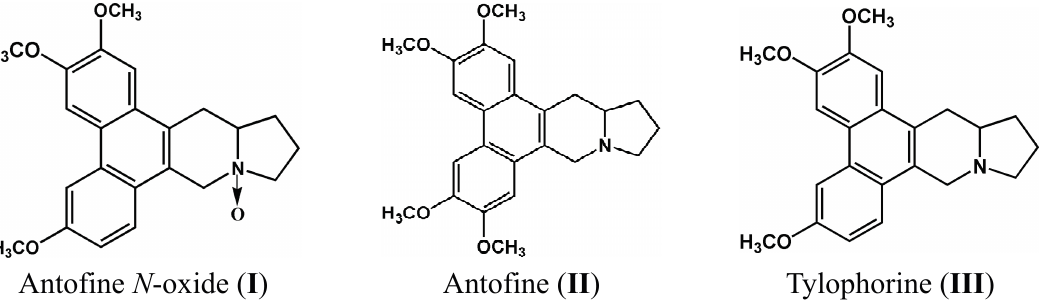
Figure 1. Structures of bioactive compounds isolated from Cynanchum mongolicum